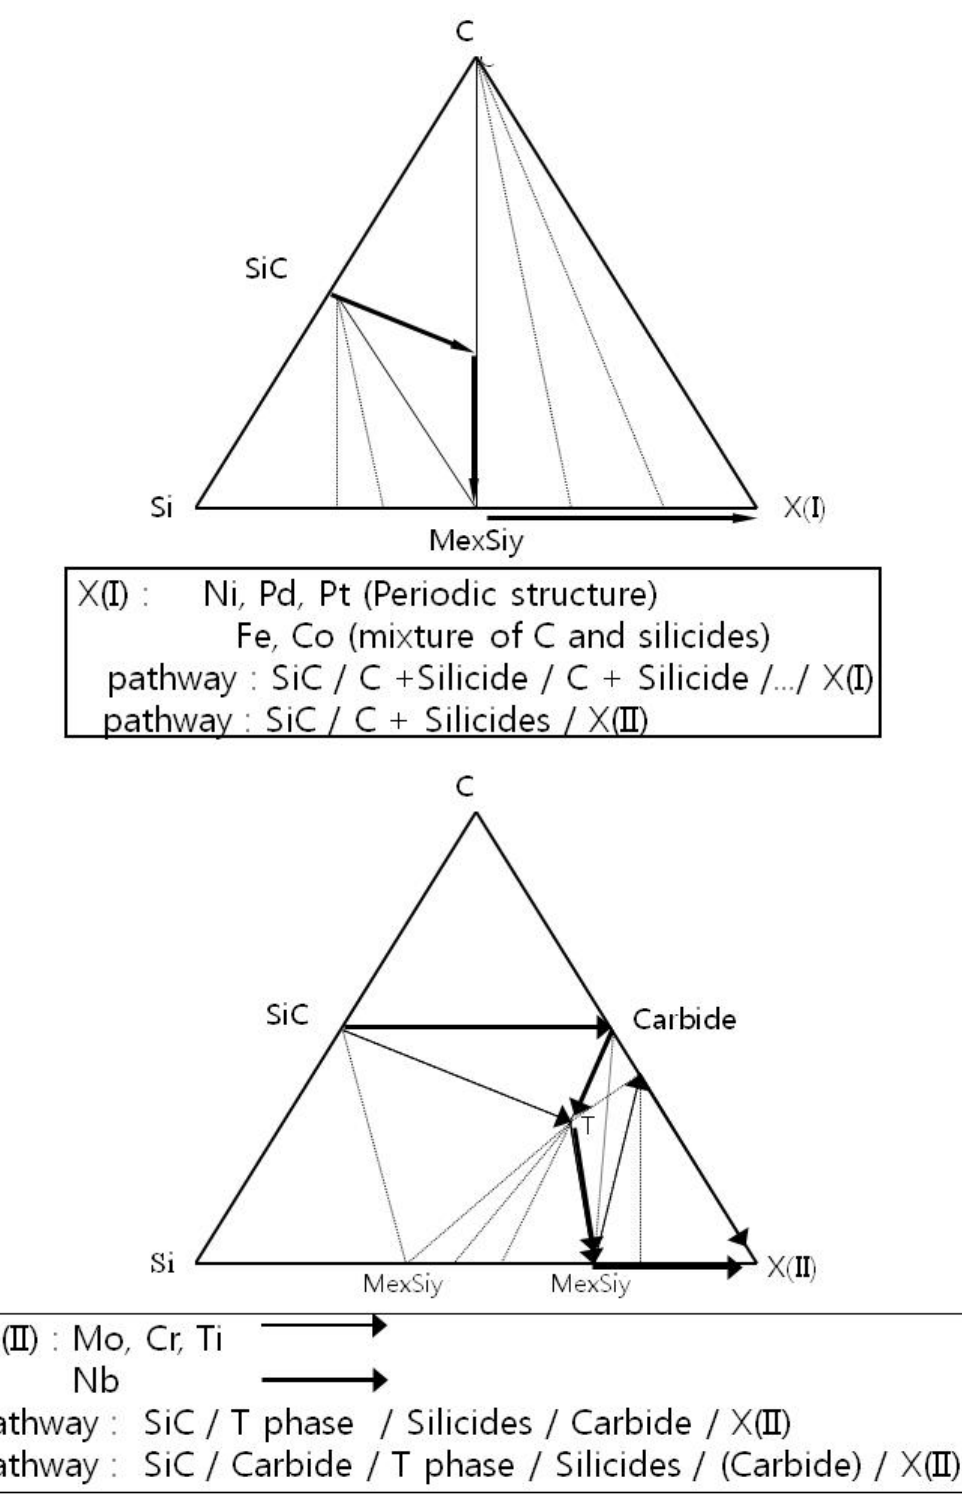
Figure 4. The schematic isothermal phase diagrams and reaction pathway of SiC/X(I) and X(II)